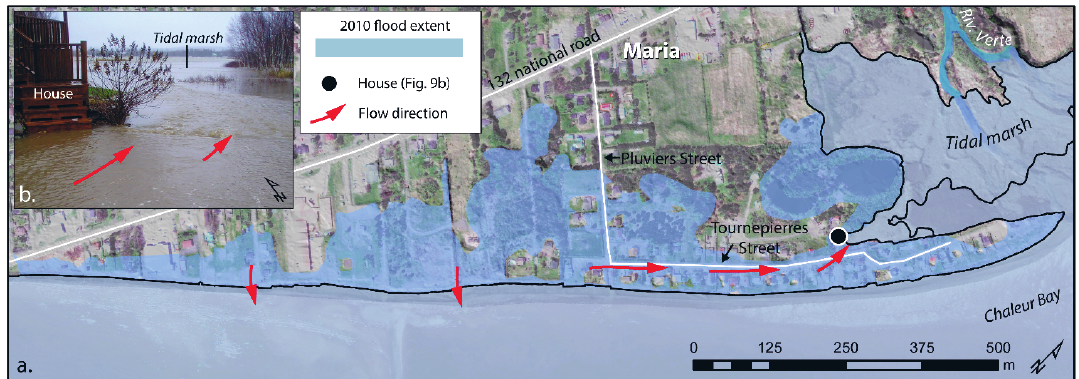
Figure 9. ( a ) Flood extent as identified during the post-storm survey and location of the